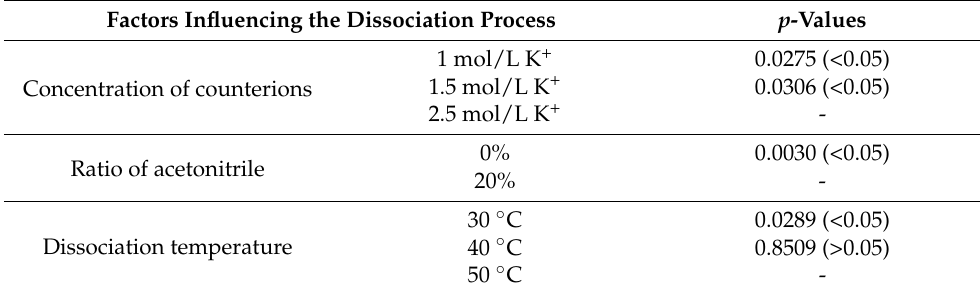
Table 5. Statistical analysis of factors influencing the dissociation process.